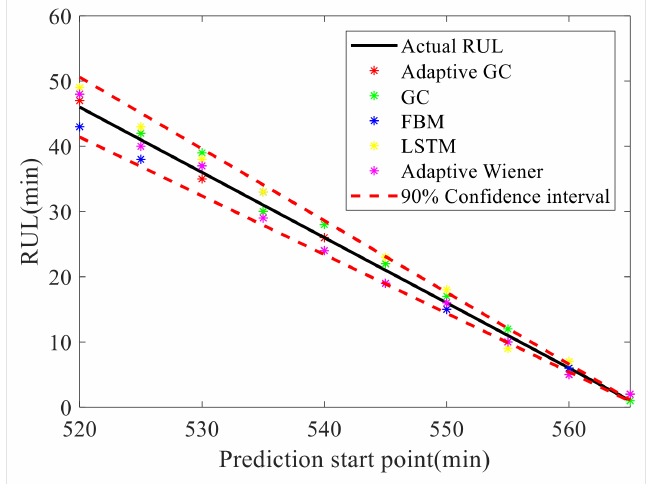
Figure 16. The RUL estimated by different prediction models. Table 5. The RUL Values Estimated by Different Prediction